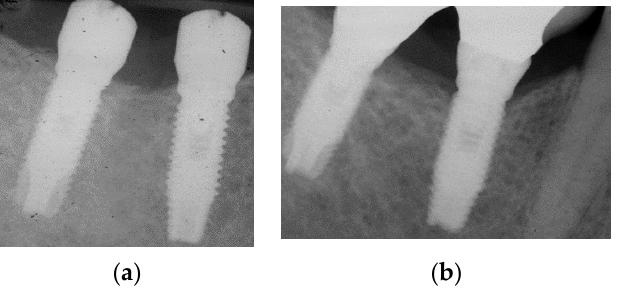
Figure 2. ( a ) Example of a periapical radiograph taken immediately after implant placement. A standard machined surface healing abutment was connected to the control implant (OSS, on the right). The test implant (FOSS, on the left) was provided with a healing abutment treated with the company’s DAE protocol; ( b ) radiograph of the same implants 16 years after implant insertion.